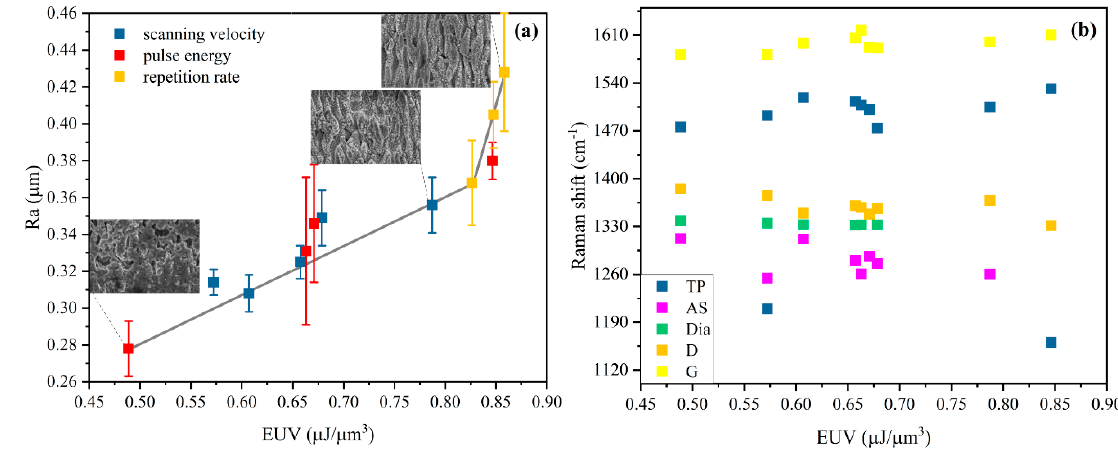
Figure 12. Re-plotted curve based on the available data obtained in this work. ( a ) The relationship between the Ra and EUV image inserts shows the corresponding morphologies of EUV connected by a dotted line. ( b ) The correlation between Raman peak position and EUV.